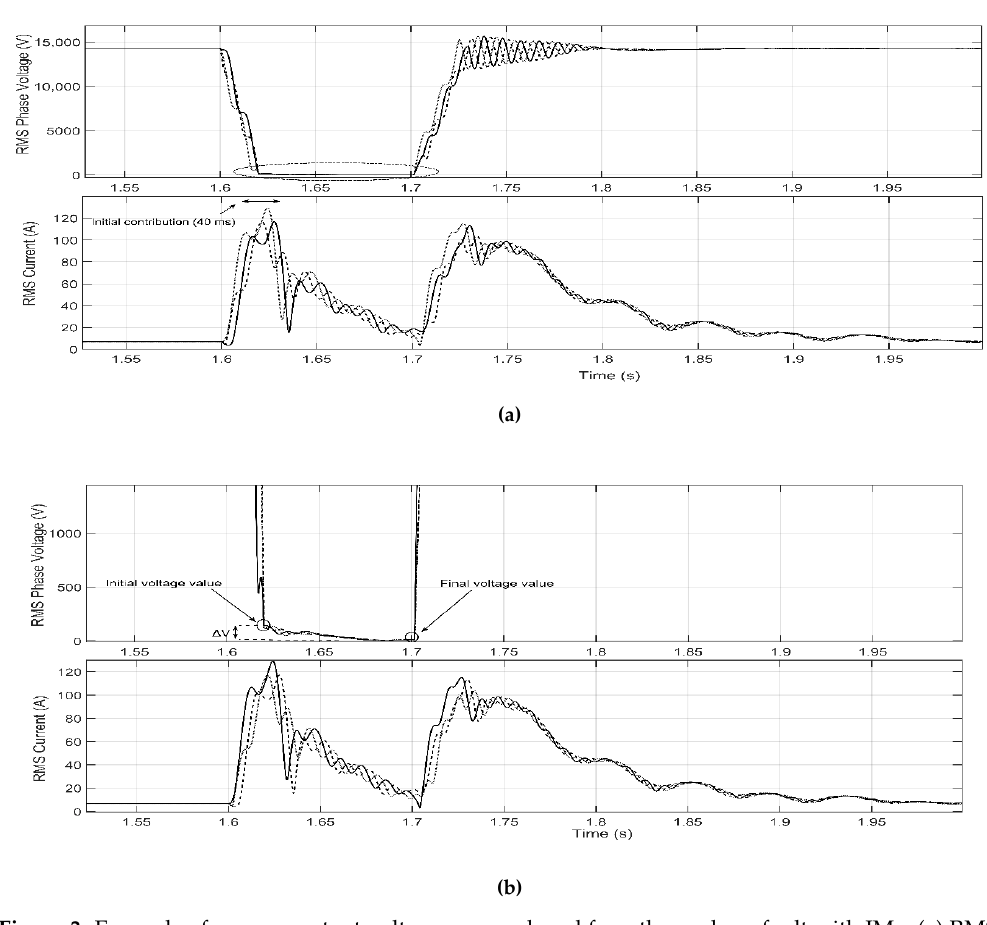
Figure 2. Example of a non-constant voltage sag produced by an induction motor (IM) start.